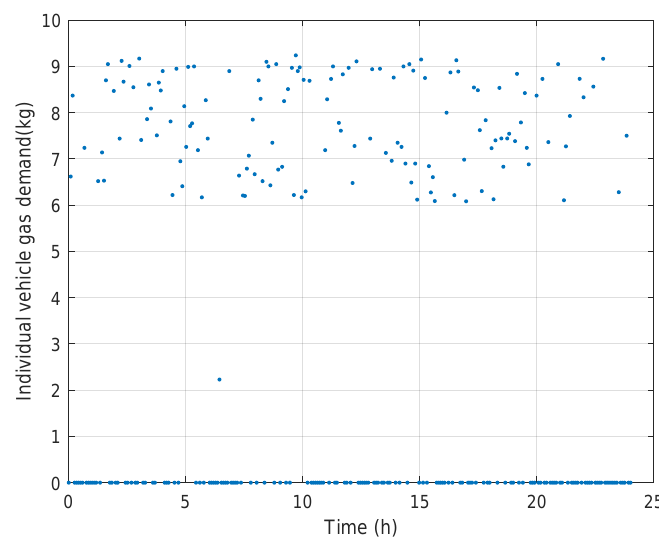
Figure 4. Individual vehicle gas demand over 24 h.